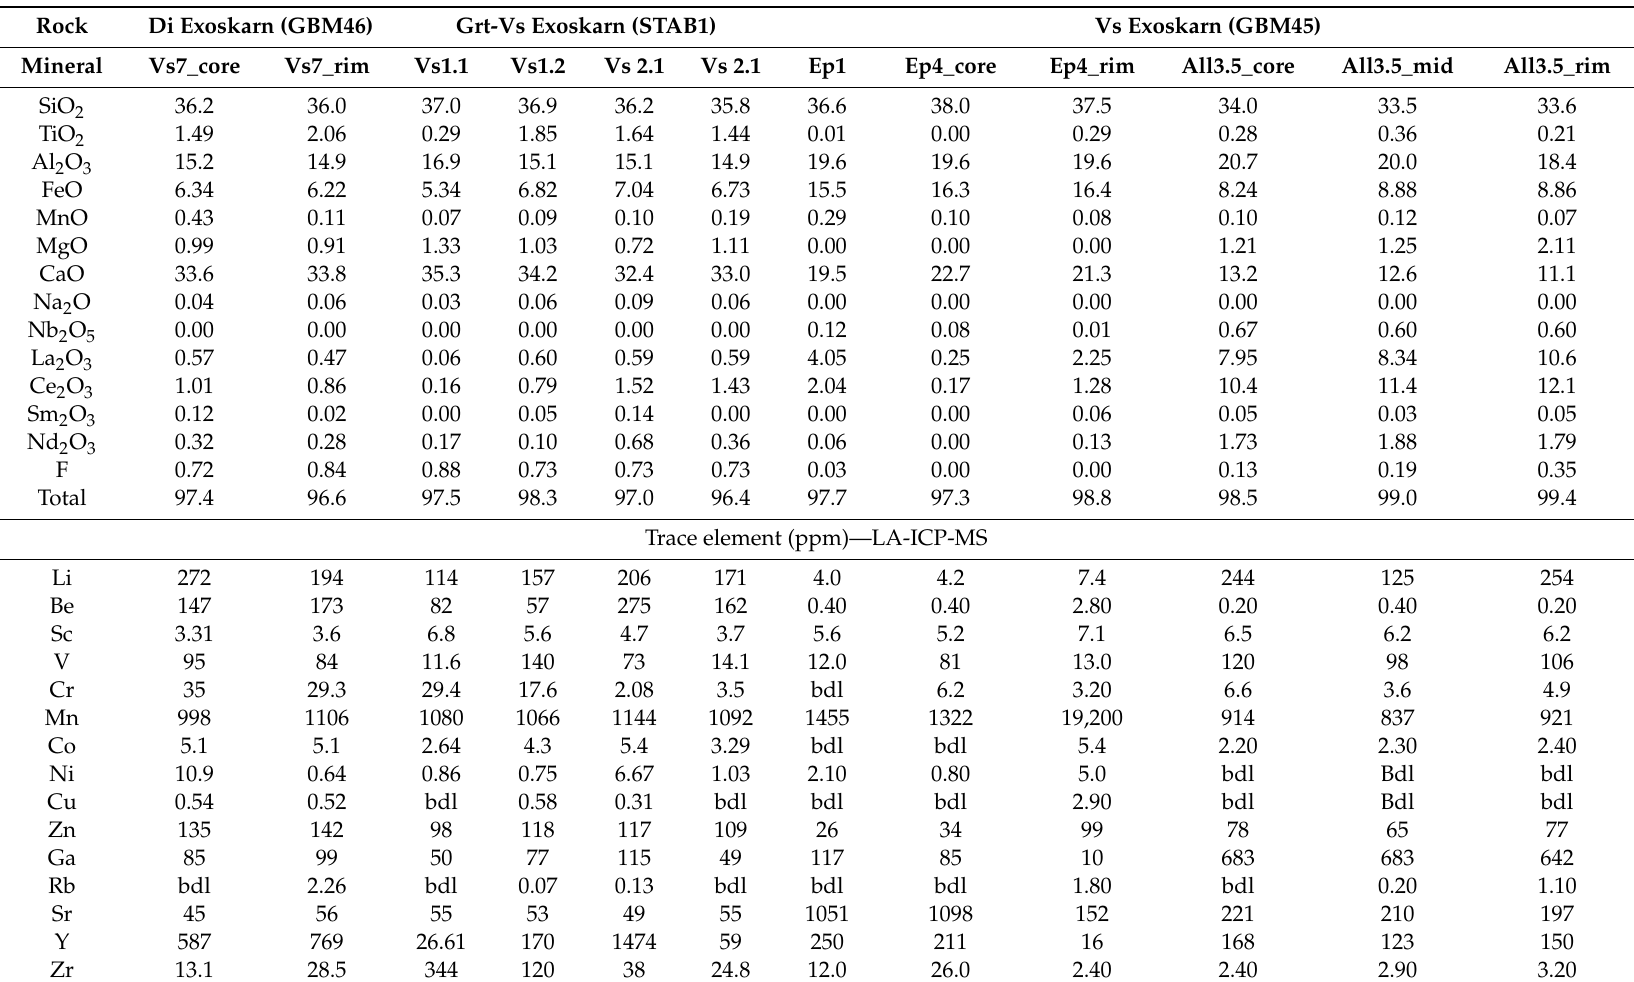
Table 5. Electron microprobe and LA-ICP-MS analyses for vesuvianite and epidote-group crystals from the BM